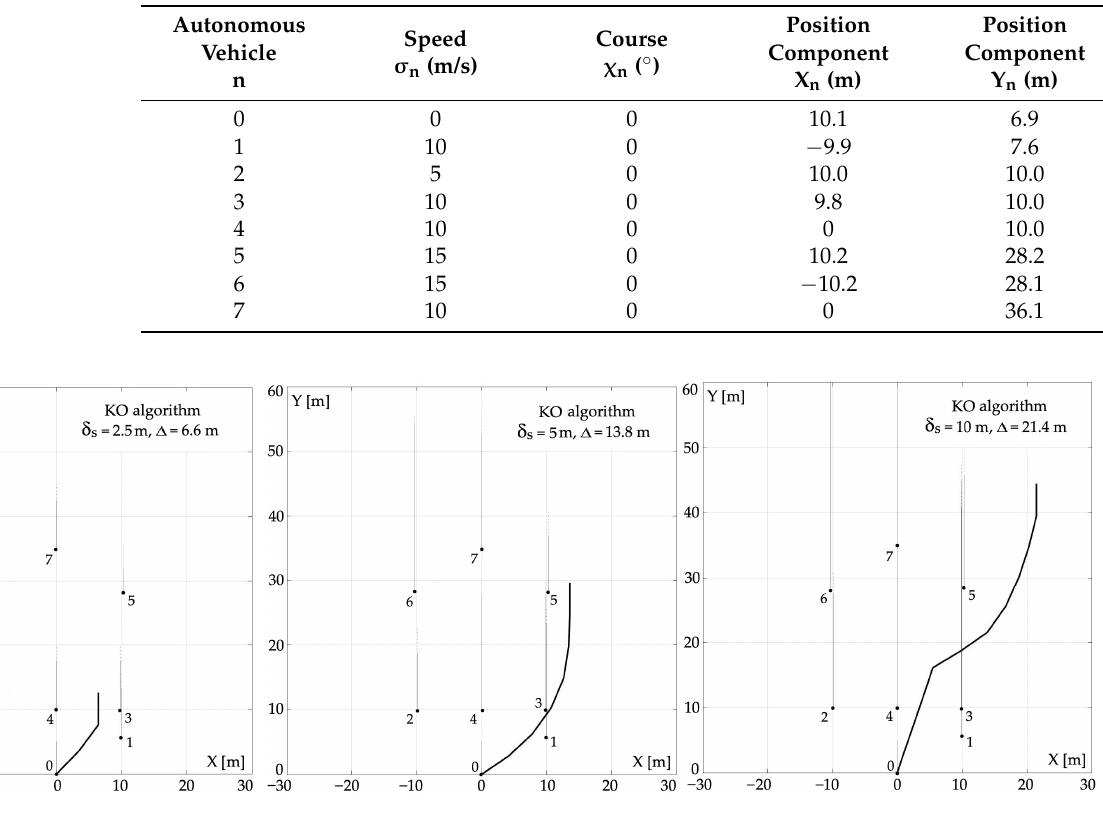
Table 3. Data of autonomous vehicles in one-way traffic.